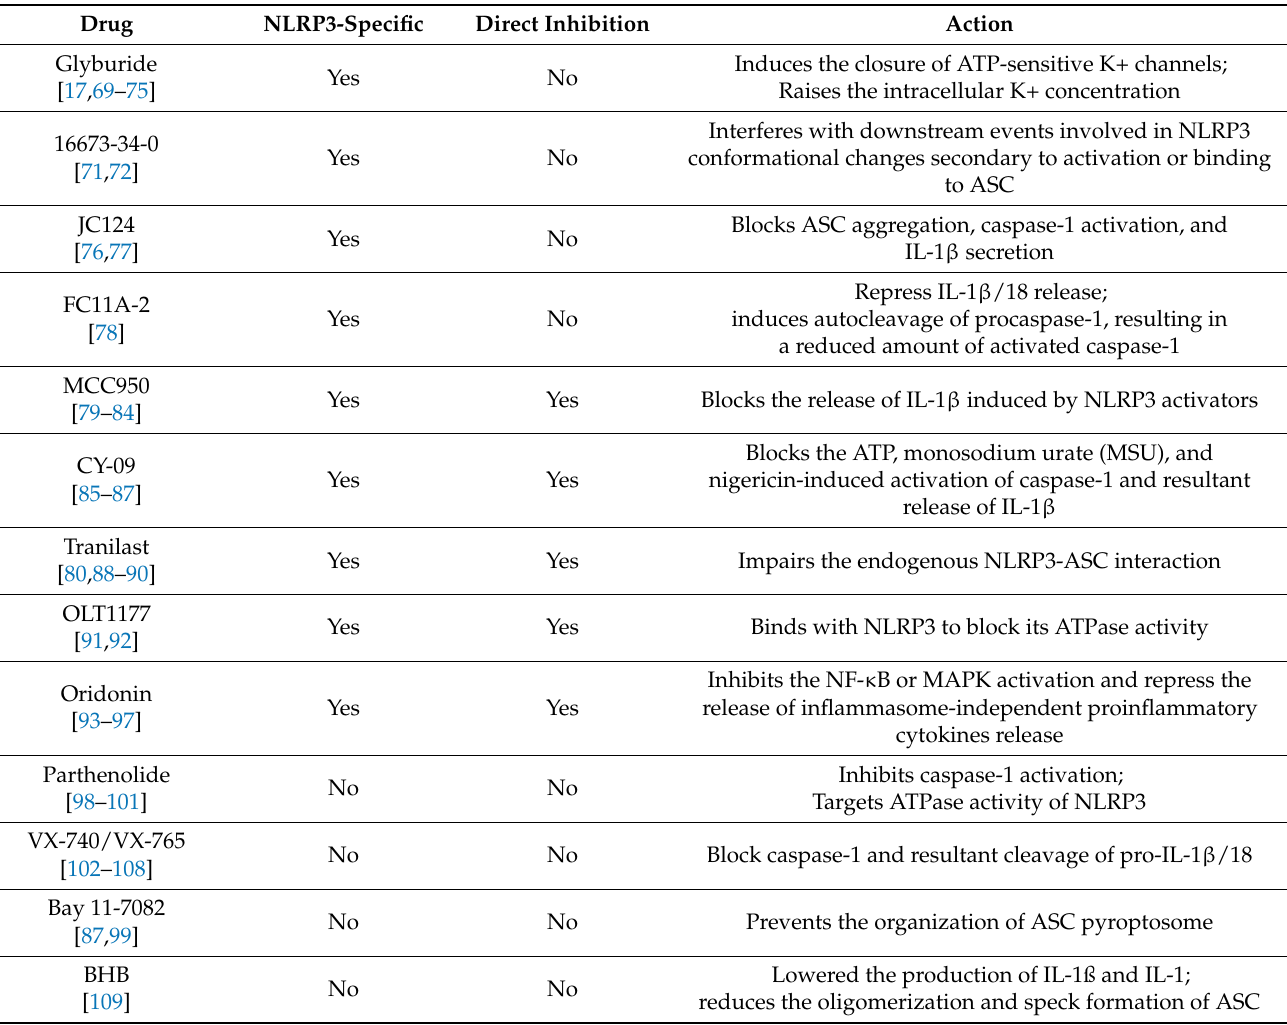
Table 1. Potential inhibitors of NLRP3 inflammasome. NLRP3-specificity and targets (including the mode of action) are also